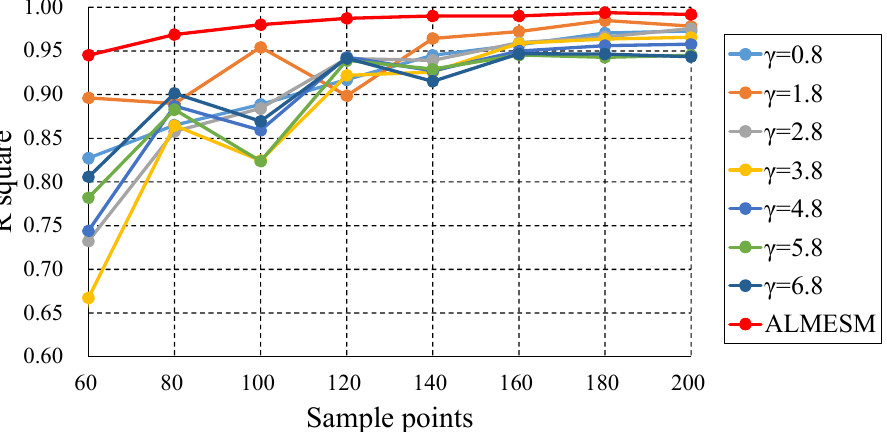
Table 2. Statistical analysis of sampling randomness of the LME and ALMESM.